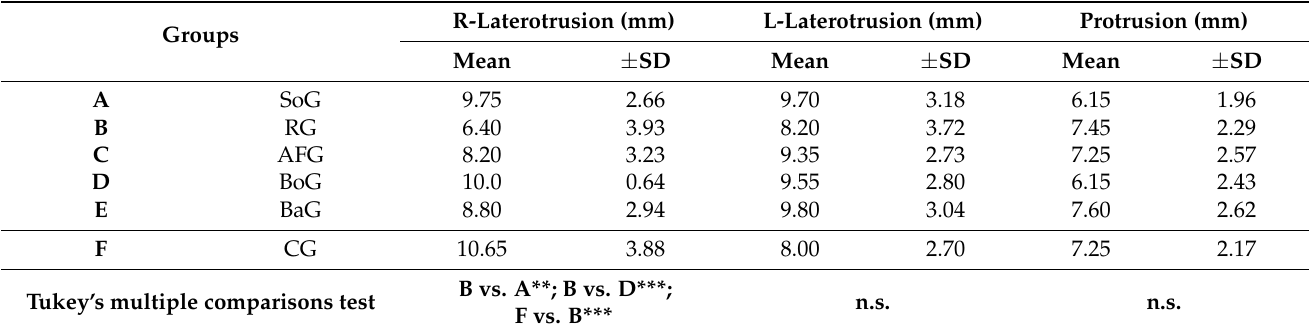
Table 10. Mean values and ± standard deviation (SD) of right and left laterotrusion and protrusion measured in Basketball group (BaG), Soccer group (SoG), American Football group (AFG), Boxing group (BoG), Rugby group (RG) and Control group (CG). Ordinary Anova and Tukey’s multiple comparisons tests were performed among the groups